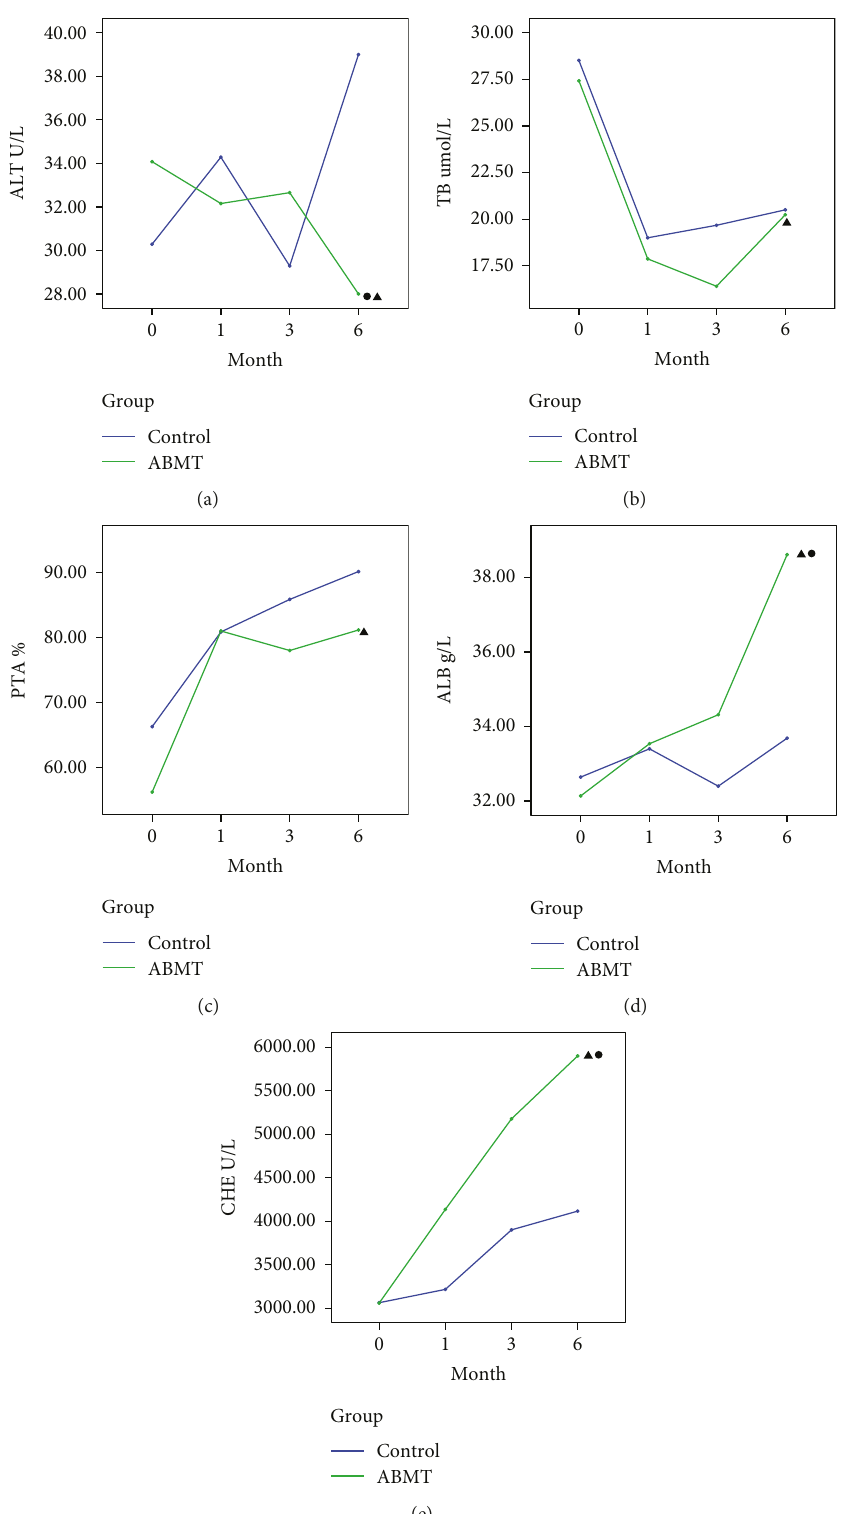
Figure 4: Changes in biochemical parameters after splenectomy or combined splenectomy and ABMT therapy in patients with decompensated liver cirrhosis: (a) ALT, (b) TB, (c) PTA, (d) ALB, and (e) CHE. ▲ P < 0 05 indicates a signi fi cant di ff erence versus the baseline value. ● P < 0 05 indicates a signi fi cant di ff erence between ABMT and control